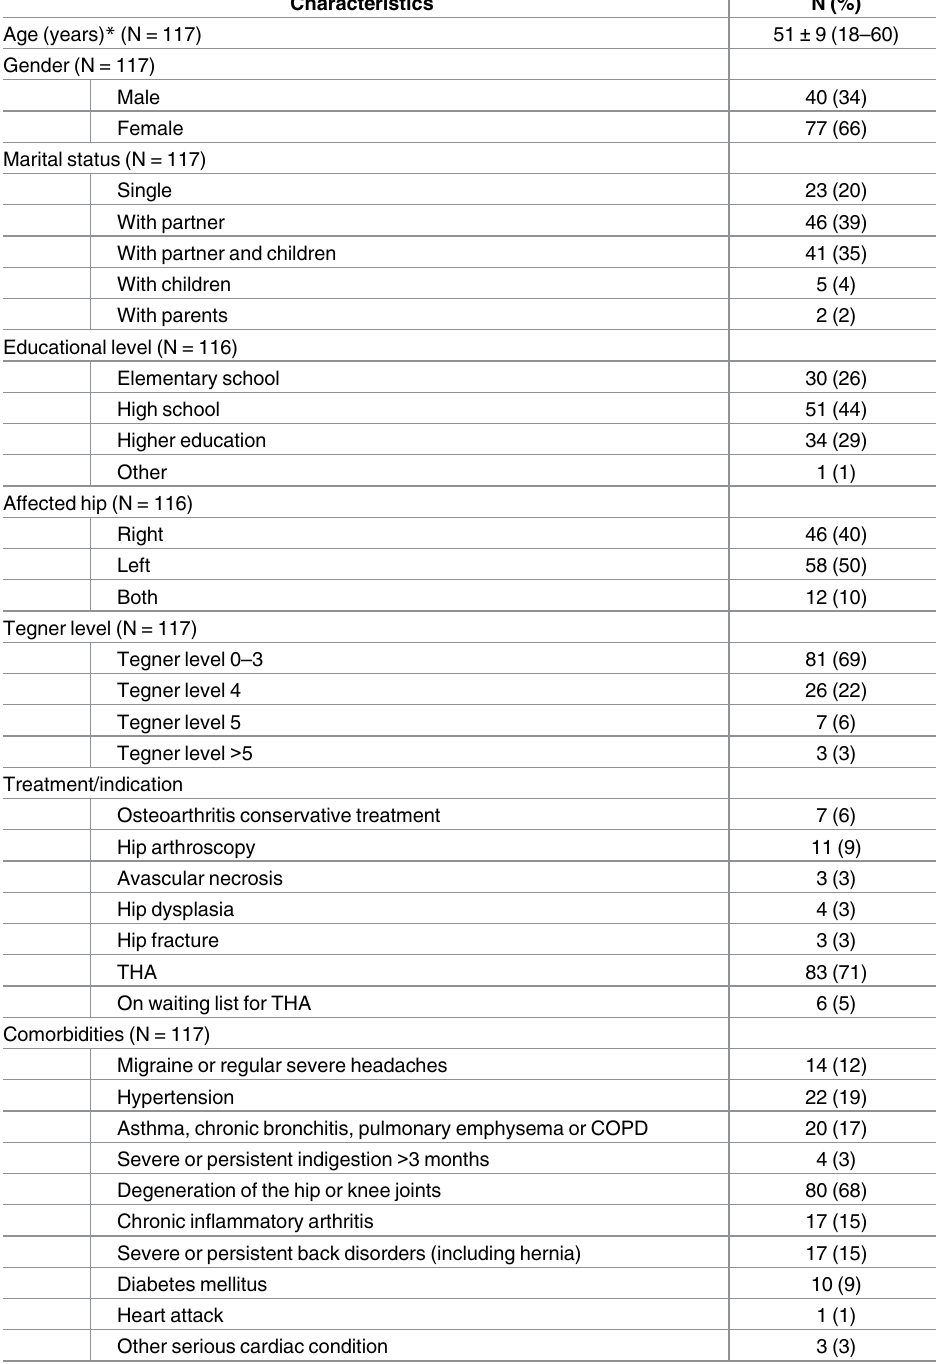
Table 2. Patient characteristics (N =